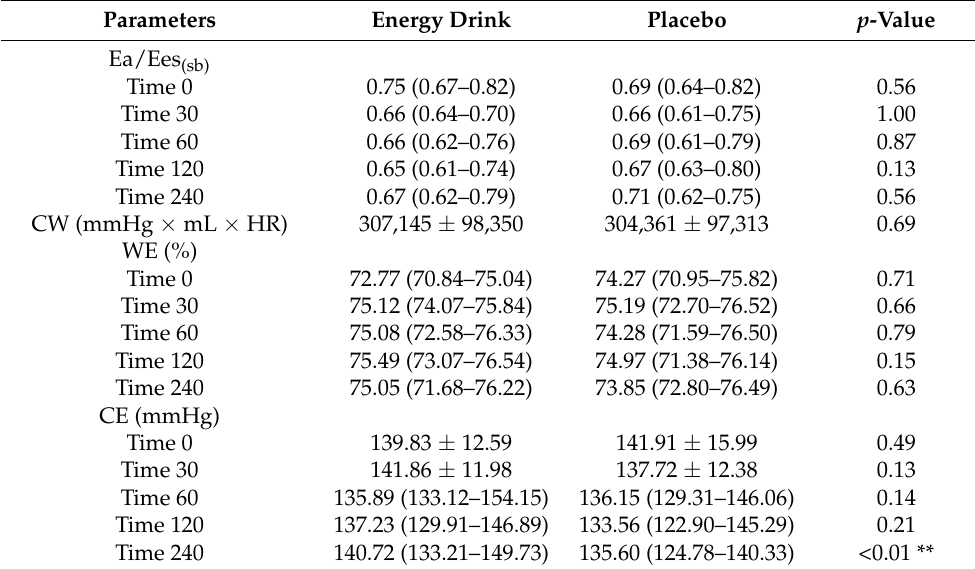
Table 4. Acute Effects of Energy Drinks on Left Ventricular Efficiency ( n = 24).